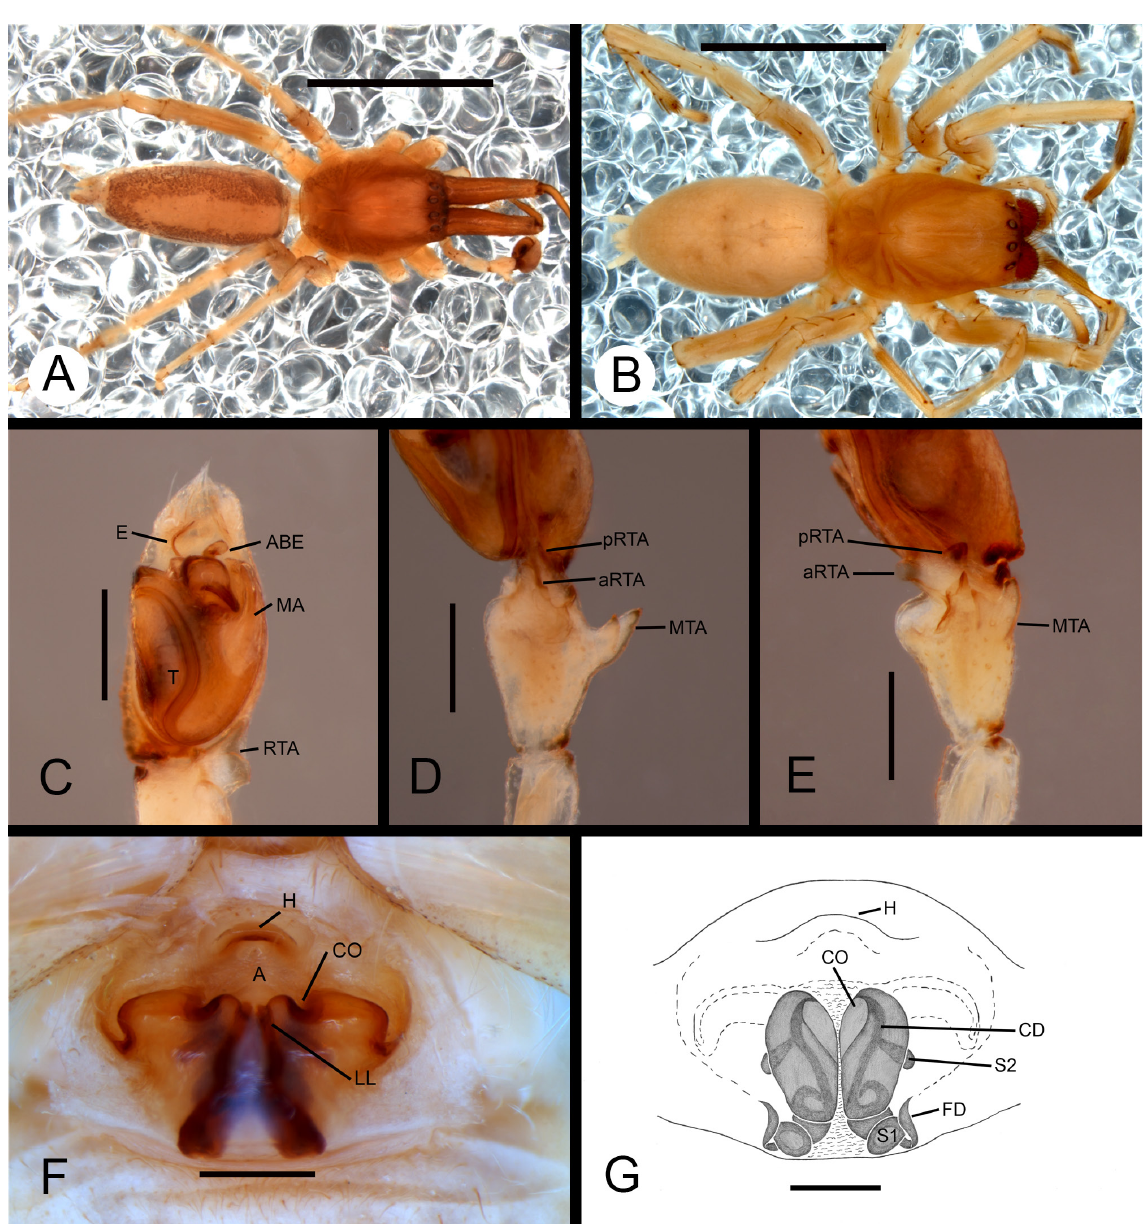
Fig. 29. Tafana oliviae sp. nov. (A, C–E = holotype, ♂, MACN-Ar 3565; B, F–G = paratype, ♀, MCZ). A . Habitus, dorsal view. B . Habitus, dorsal view. C . Left palp, ventral view. D . Left palp, retrolateral view. E . Left palp, retrolateral view. F . Epigynum, ventral view. G . Vulva, dorsal view. Abbreviations: A = atrium; ABE = apophysis of base of the embolus; aRTA = anterior branch of the retrolateral tibial apophysis; CD = copulatory ducts; CO = copulatory opening; E = embolus; FD = fertilization ducts; H = hood; LL = lateral lobes; MA = median apophysis; MTA = median tibial apophysis; pRTA = posterior branch of the retrolateral tibial apophysis; RTA = retrolateral tibial apophysis; S1 = primary spermathecae; S2 = secondary spermathecae; T = tegulum. Scale bars: A–B = 3.5 mm; C–G = 0.25